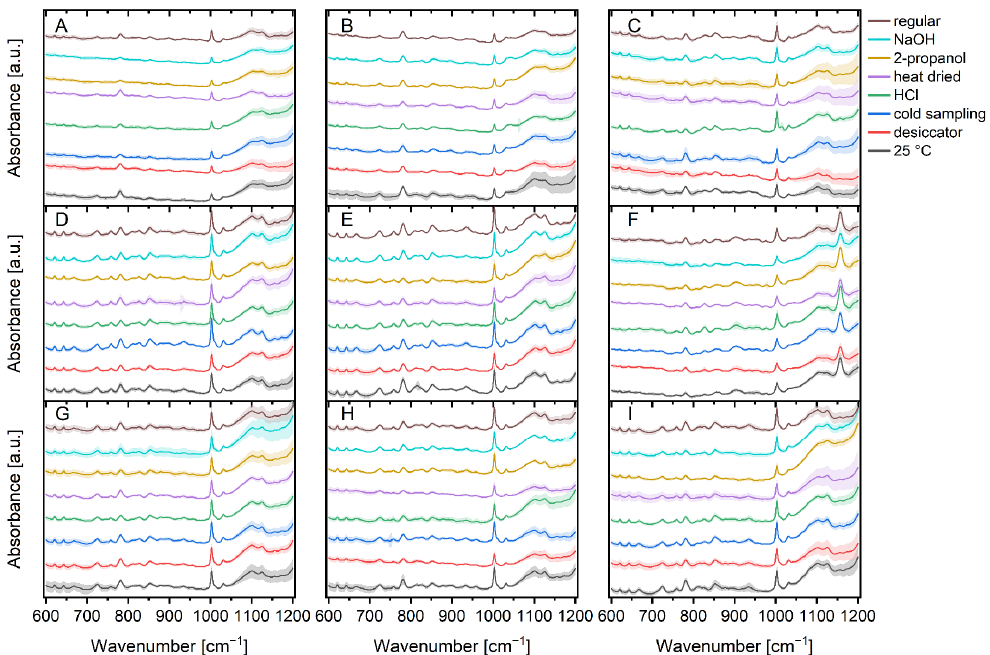
Figure 2. Stacked mean Raman spectra of the normalized data of a total of 5,450 spectra subdivided into seven stress conditions and regular treatment of B. sub ( A ), B. therm ( B ), B. tii ( C ), E. coli K12 ( D ), E. coli HB101 ( E ), M. luteus ( F ), Ps. fluor 4358 ( G ), Ps. fluor 50090 ( H ) and E. coli TOP10 ( I ). Pale colored bands around the mean value represent the standard deviations.